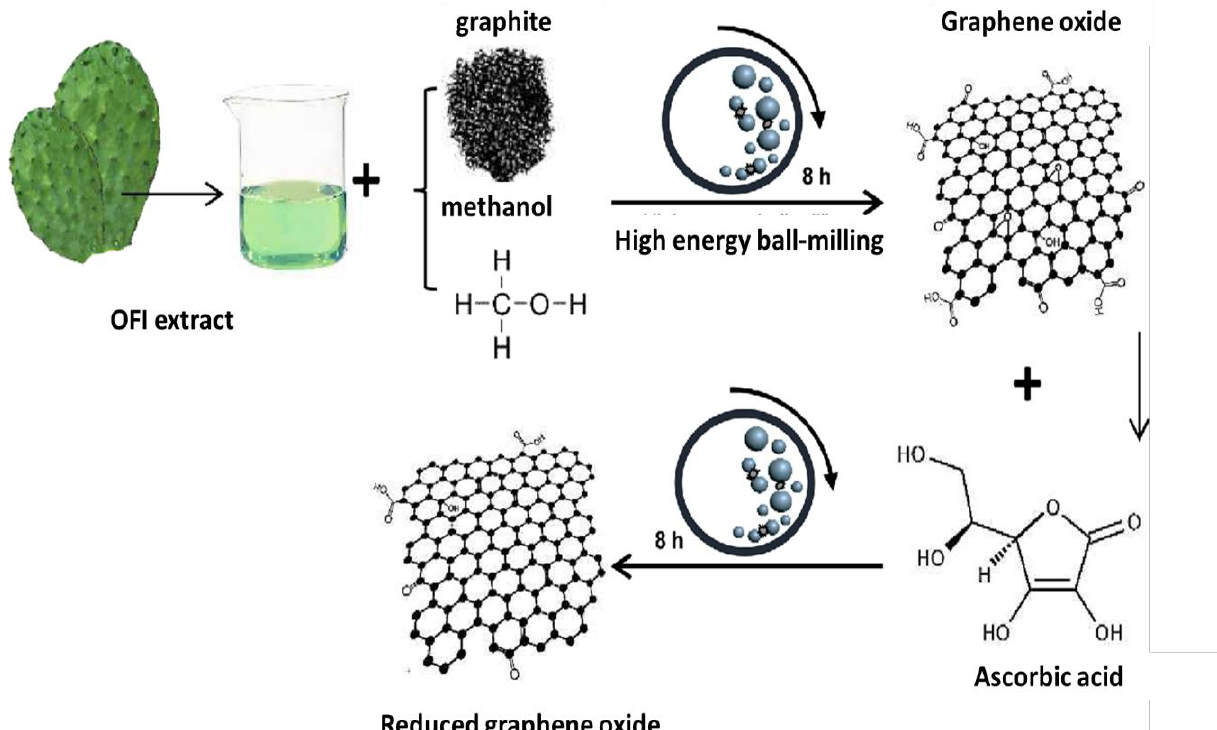
Figure 6. Sustainable production of rGO via high-energy ball milling using the reducing agent Opuntia ficus-indica (OFI) plant extract. Reproduced from [33], copyright 2017, Springer.